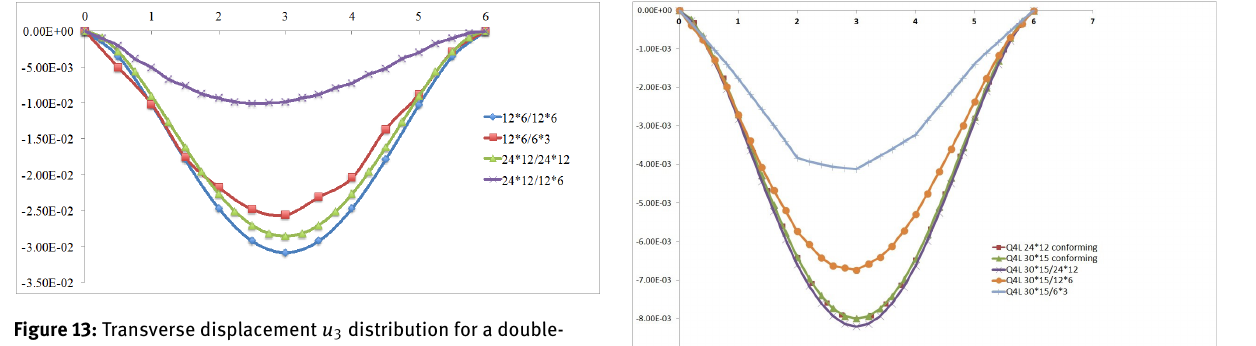
Figure 13: Transverse displacement u 3 distribution for a double- layer shell with DKQ elements using conforming and non- conforming mesh configurations.